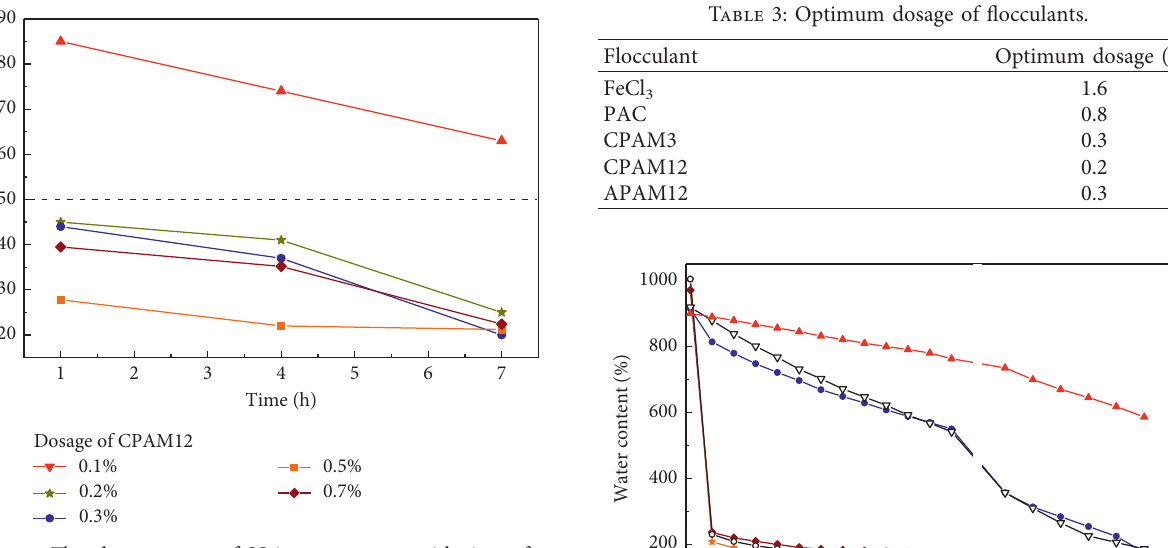
Figure 5: The change curve of SS in supernatant with time after adding CPAM12.